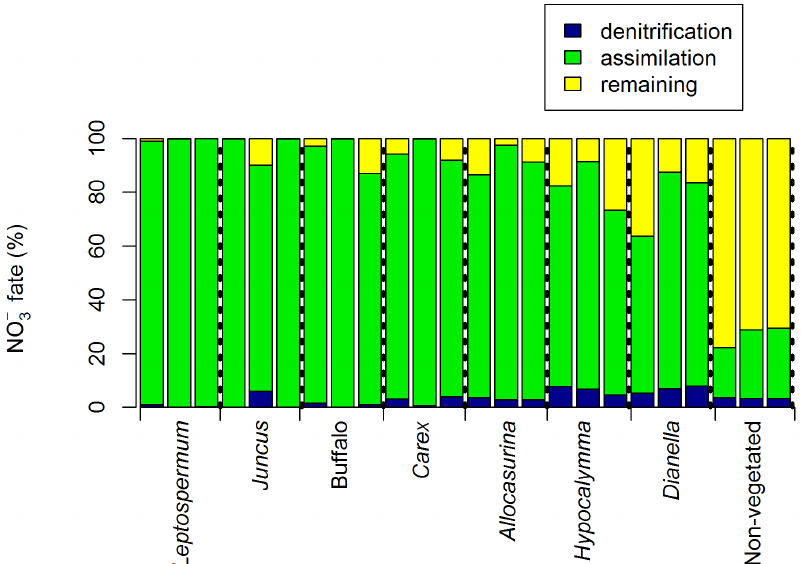
Figure 6. Division of 15 NO 3 2 between denitrification, plant or microbial assimilation or remaining in the pore water. Results for each biofilter column in the multiple species experiment (3 replicates per species, n=1).